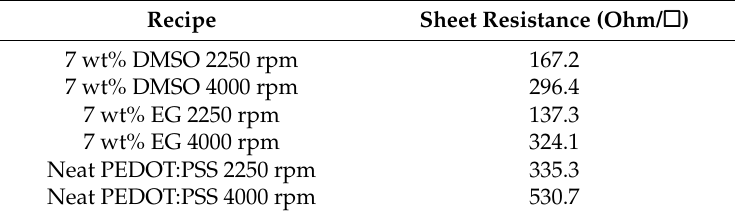
Table 1. The electrical properties of the PEDOT:PSS films spin-coated for 300 s on untextured substrates. Recipe